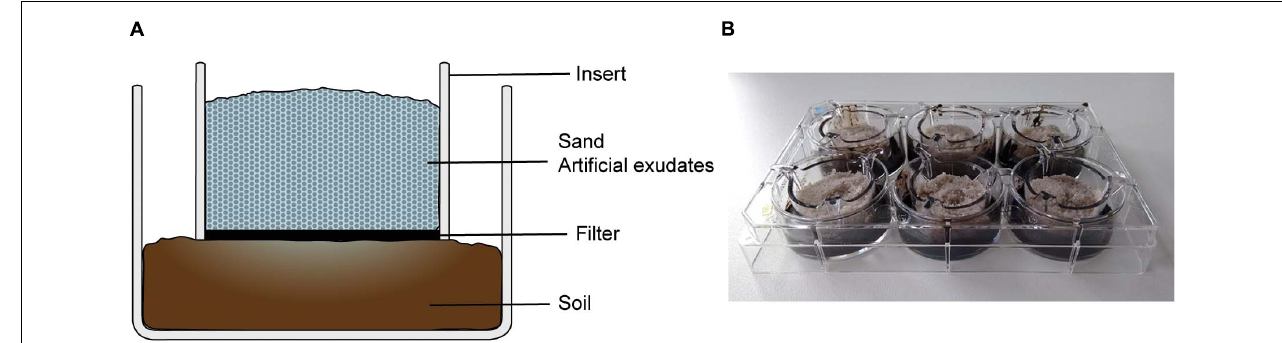
FIGURE 1 | Setup of rhizosphere simulation microcosms in a two-compartment well with insert. (A) In a microcosm, the lower compartment contained arable soil, the upper compartment (insert) was filled with sterile sand mixed with artificial exudates. A permeable filter separates the compartments, which allows the diffusion of artificial exudates from the sand in the soil, simulating root exudation. (B) Setup of six microcosms in a six-well plate with